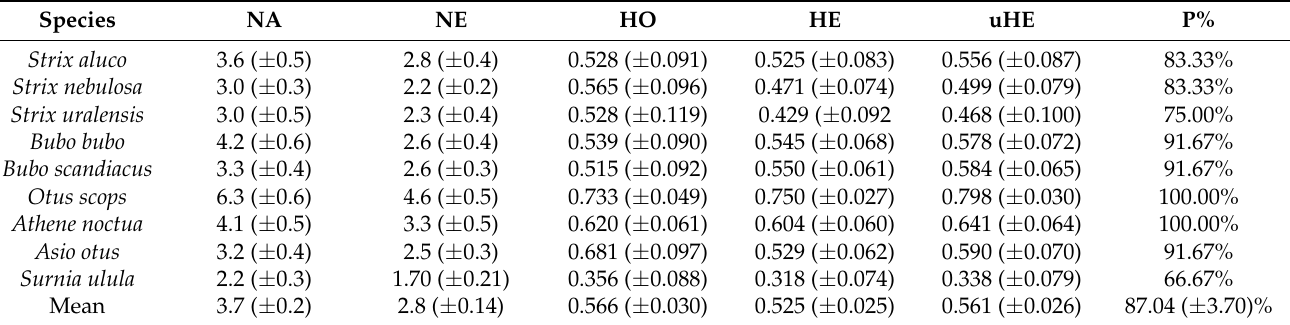
Table 3. Variability indices: Allele number (NA), effective allele number (NE); observed heterozygosity (HO), expected heterozygosity (HE), unbalanced expected heterozygosity (uHE), percentage of polymorphic loci (P%). Standard errors are shown in brackets.